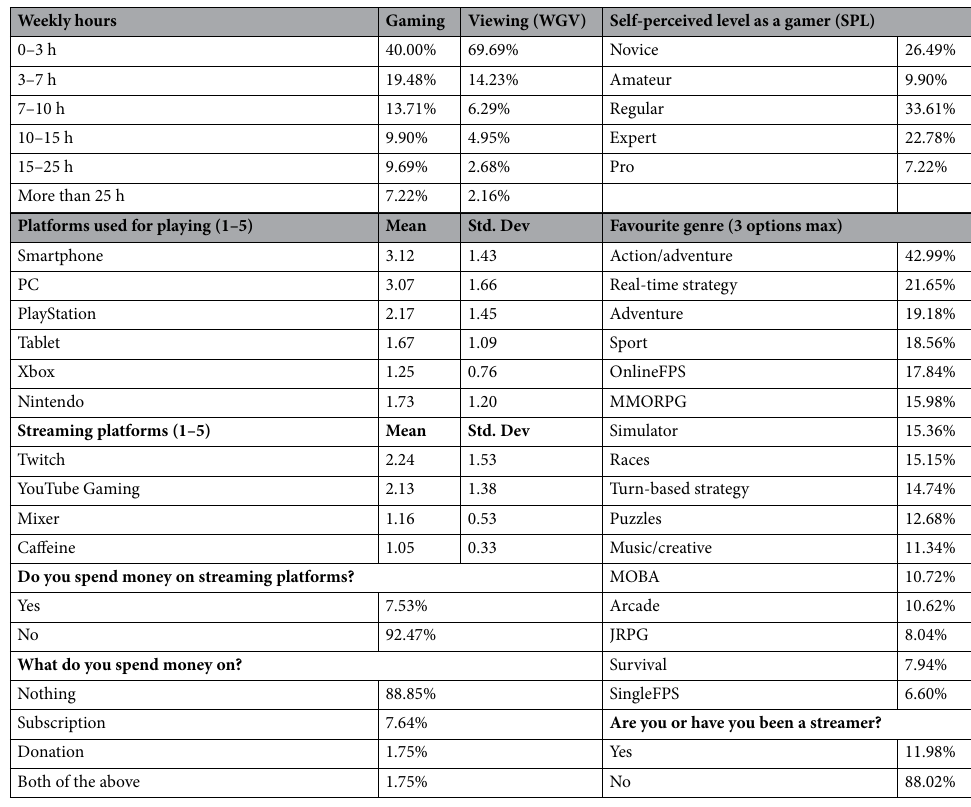
Table 2. Respondents’ gamer